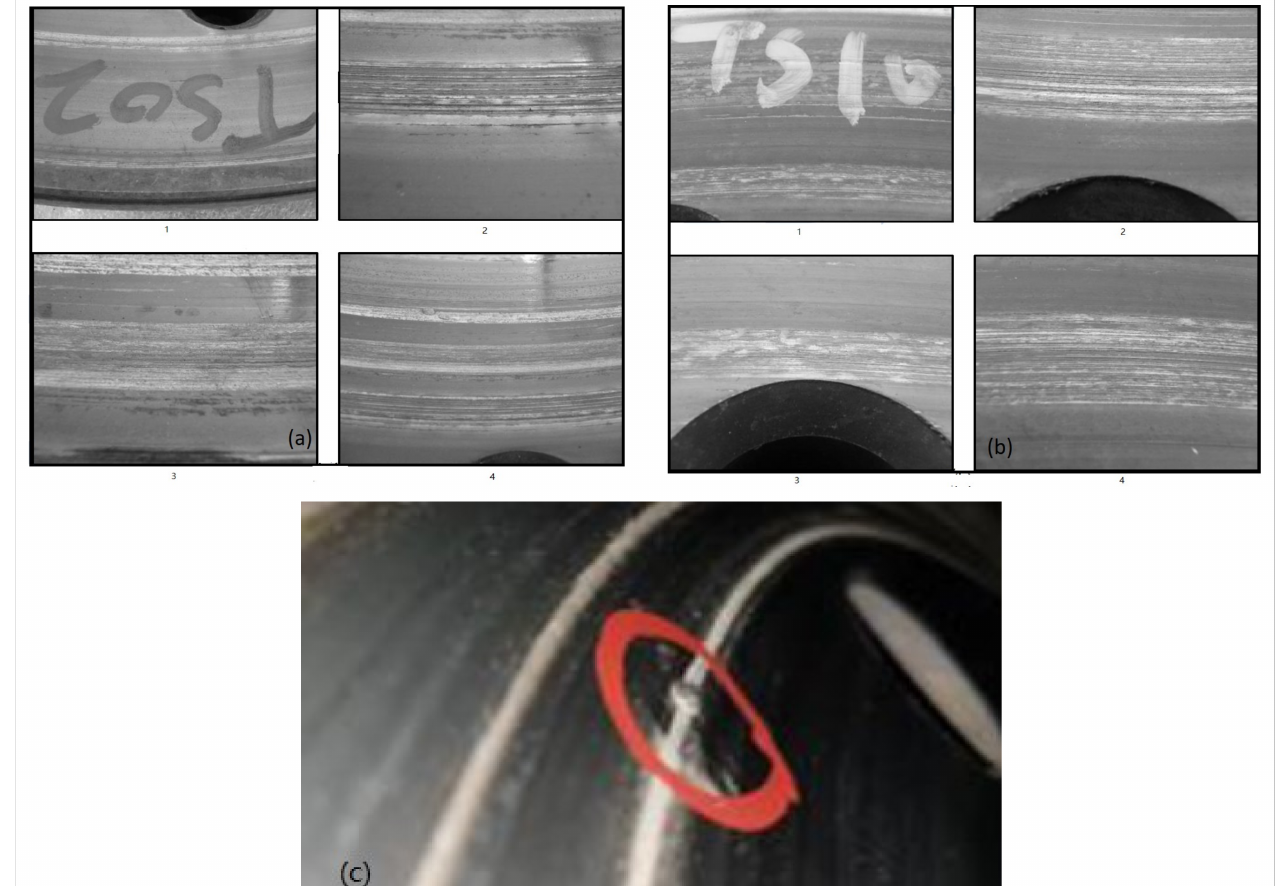
Figure 3. ( a ) Detailed views of the braking surface of Disc 1 from the affected trainset, ( b ) Detail views of the braking surface of Disc 2 from an unaffected trainset. ( c ) Example of a welding